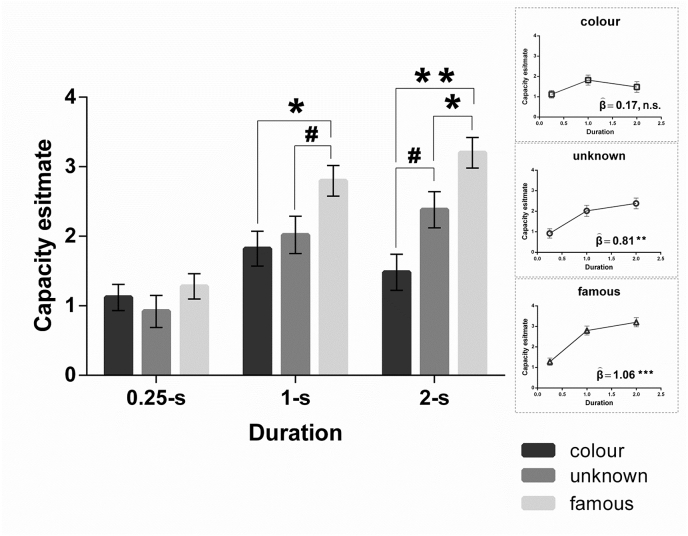
Capacity estimates (Cowan's K), representing the number of correctly remembered items, displayed as a function of the types of stimuli by encoding durations. * represents 0.05 > p > .01; ** represents 0.01 > p > .001; *** represents p < .001; # represents marginal significance (0.1 > p > .05).